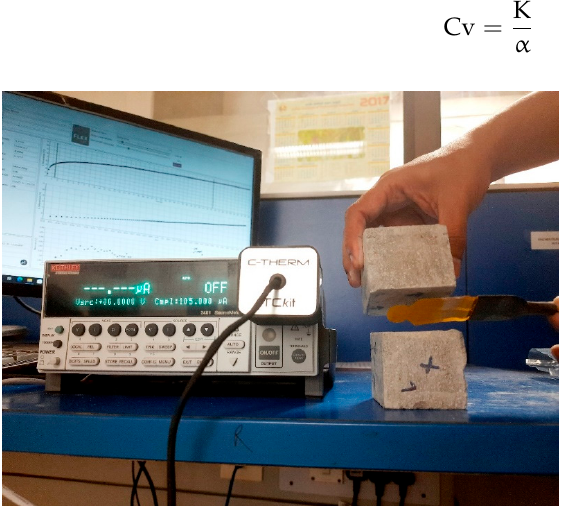
Figure 6. Thermal conductivity measurement of 3D printed cubes using transient plane source.